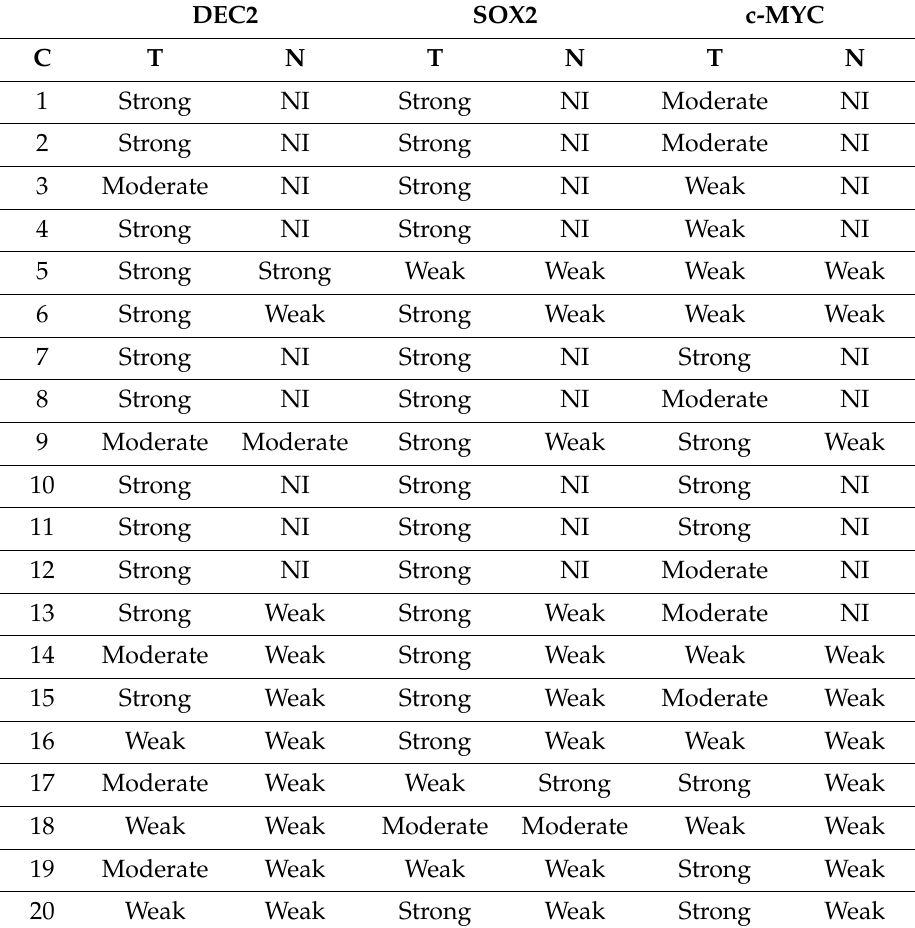
Table 2. Immunohistochemical detection of DEC2, SOX2 and c-MYC proteins in human cervical cancer